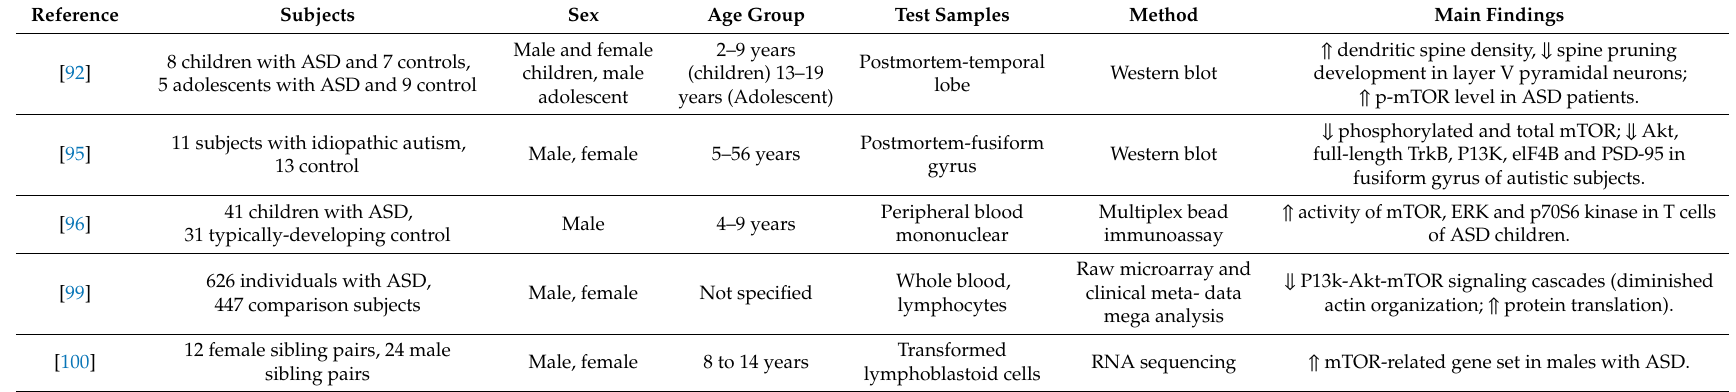
Table 5. Summary for previous evidence on dysregulation of mTOR signaling pathway in